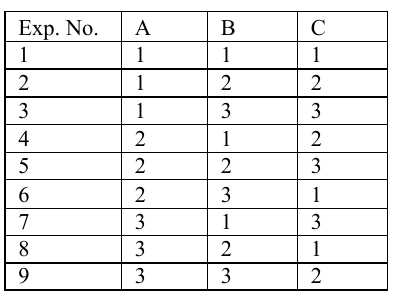
Table 2. Experimental combinations given in L9 array Exp. No.